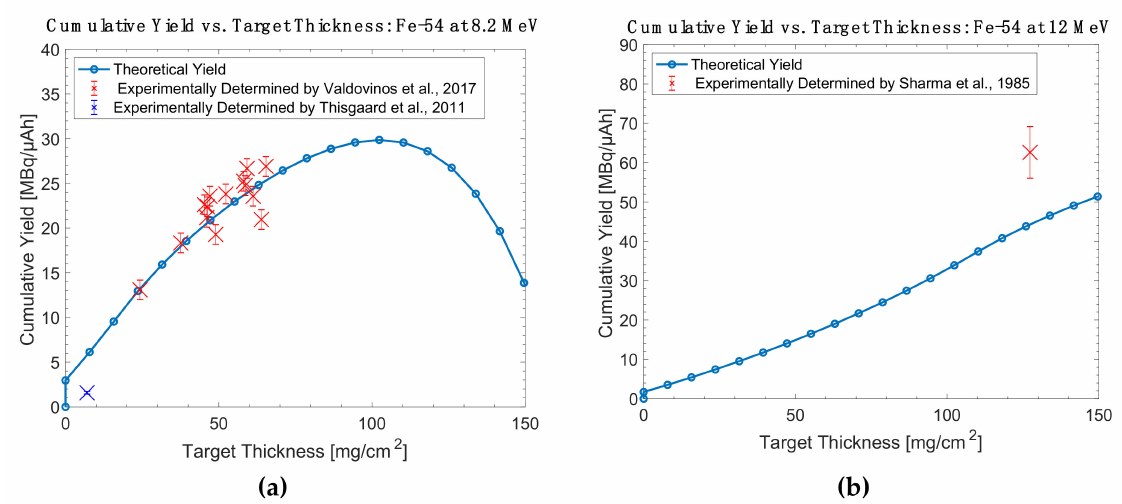
Figure 13. Thick target yield comparison between theoretical data and experimentally collected data for iron-54 targets at ( a ) 8.2 MeV and ( b ) 12 MeV